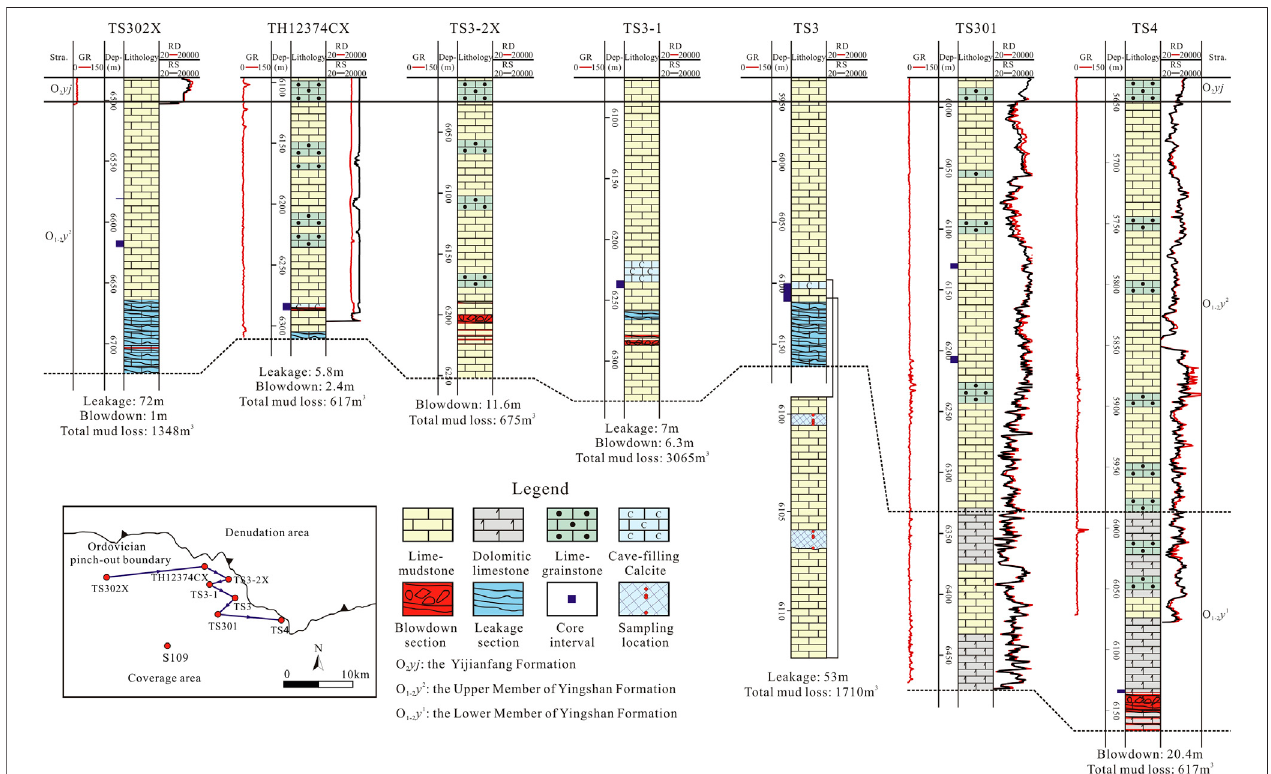
FIGURE 3 | The distribution of different lithology, blowdown, and leakage in the coverage area of Tahe Oil fi eld. Some wells lack logging curves due to blowdown and leakage.